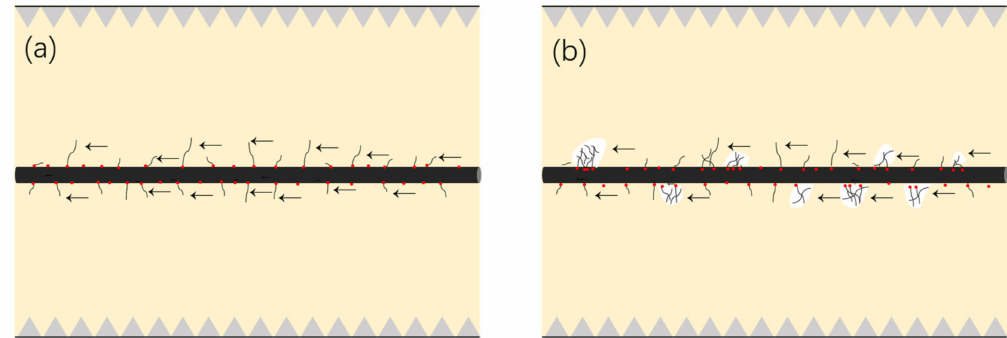
Figure 4. Schematic diagrams of carbon nanotube (CNT) enhancement: ( a ) optimal concentration of grafted CNTs; ( b ) a high concentration of CNTs. (The red dots indicate melamine, the arrows indicate the resistance to shearing forces, and the white parts indicate resistance to resin penetration.)